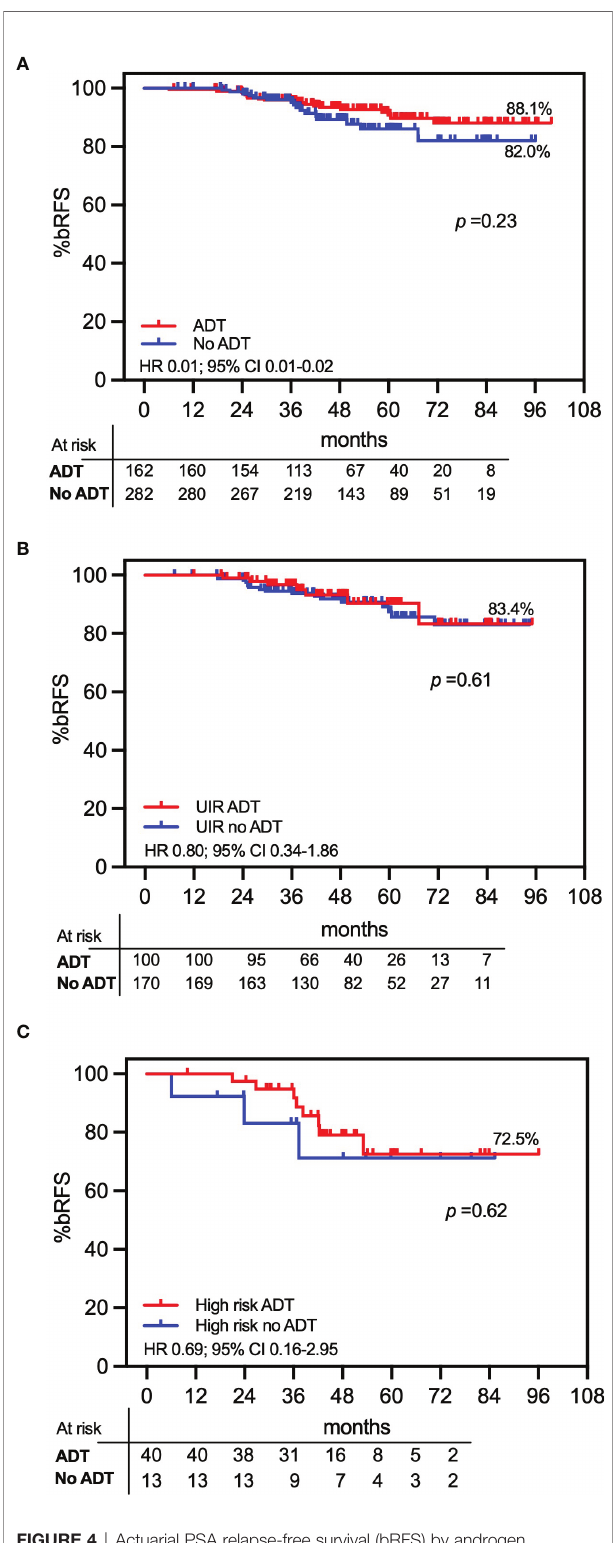
FIGURE 4 | Actuarial PSA relapse-free survival (bRFS) by androgen deprivation therapy (ADT). Patients treated with ADT are compared with patients not receiving ADT. (A) The total study population of 444 patients; (B) unfavorable intermediate-risk (UIR) patients; (C) high-risk